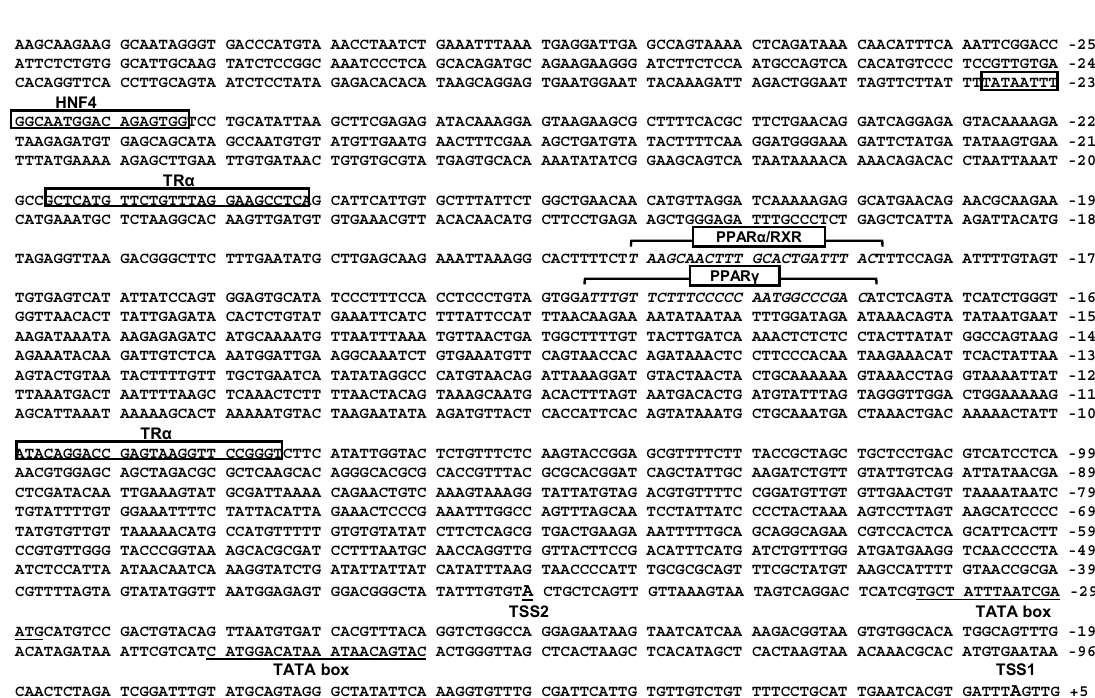
Figure 3. Nucleotide sequence of grass carp CPT I α 1b promoter. +1 denoted the transcription start site ( TSS1 ) obtained from RLM-5 ′ RACE experiment. TSS2 presented another transcription start site ( − 346, TSS ′ ). Numbers indicated the distance from TSS1. The highlighted sequences show putative transcription factor binding sites.